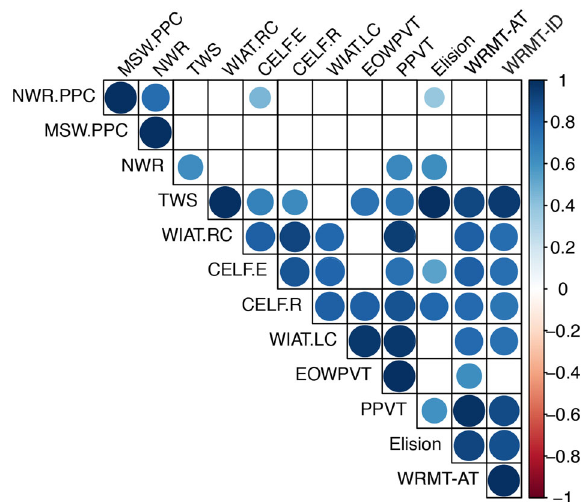
Fig. 1 Genetic correlation matrix across traits in CFSRS. Figure 1 shows cross-trait correlation results for each pair of tests using GCTA ’ s bivariate REML analysis 69 . The cross-trait correlation was tested under the null hypothesis of 0 correlation. Circles shown are for results signi fi cant at p < 0.05, with increasing diameter/color corresponding with increasing correlation (circles omitted other- wise). Traits: Phonological memory MSW.PPC, MSW, NSW, NSW.PPC), Spelling (TWS), Reading (WRMT-ID, WRMT-AT, WIAT-RC), Language (CELF.E, CELF.R, WIAT.LC), Vocabulary (EOWPVT, PPVT), phonological awareness